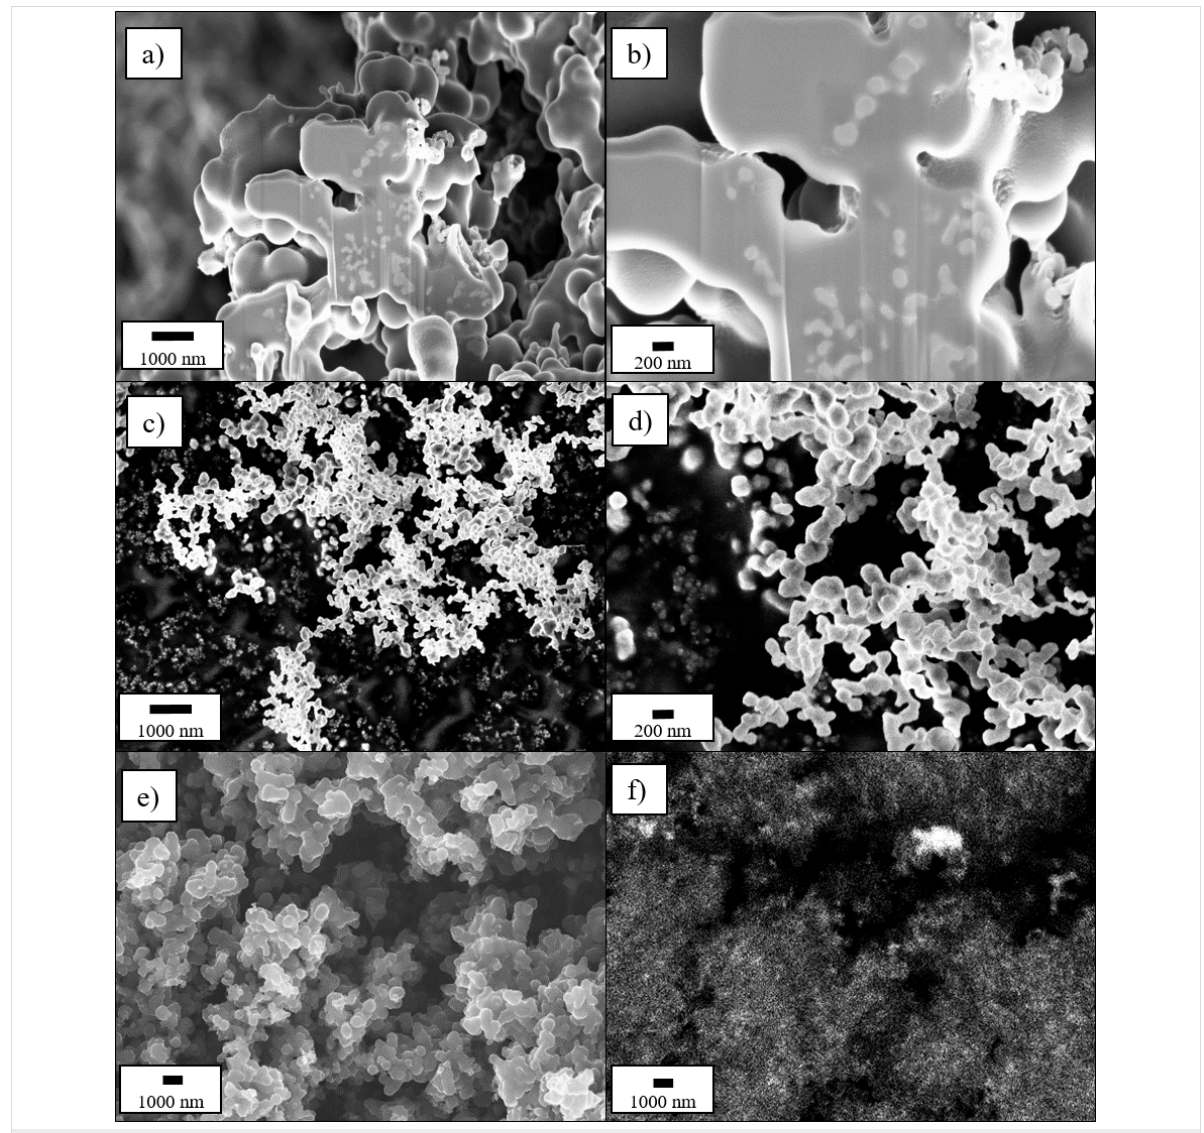
Figure 2: FIB-SEM cross section of the C:Si 80:20 composite (a, b) and SEM micrographs of the pure Si-NPs (c, d) and an EDX mapping of the C:Si 80:20 composite, showing the Si distribution (=white areas) within the matrix (f) and the corresponding SEM micrograph (e).